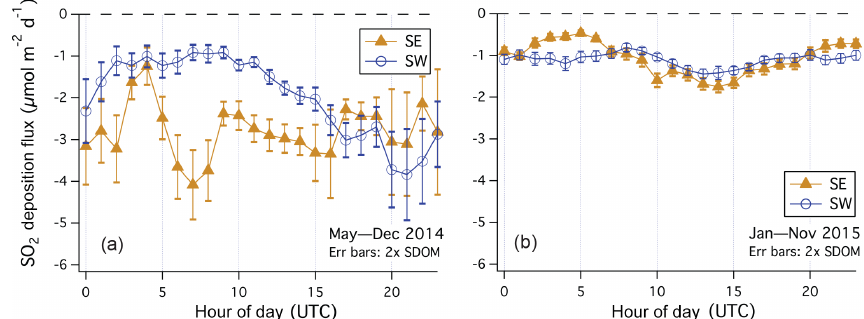
Figure 7. Mean diel cycles in the wind speed-dependent SO 2 deposition flux, separated into the southeastern and southwestern wind sectors for year 2014 (a) and 2015 (b) . Error bars indicate 2 standard errors. SO 2 deposition flux was significantly greater in the southeastern sector than in the southwestern sector in 2014.